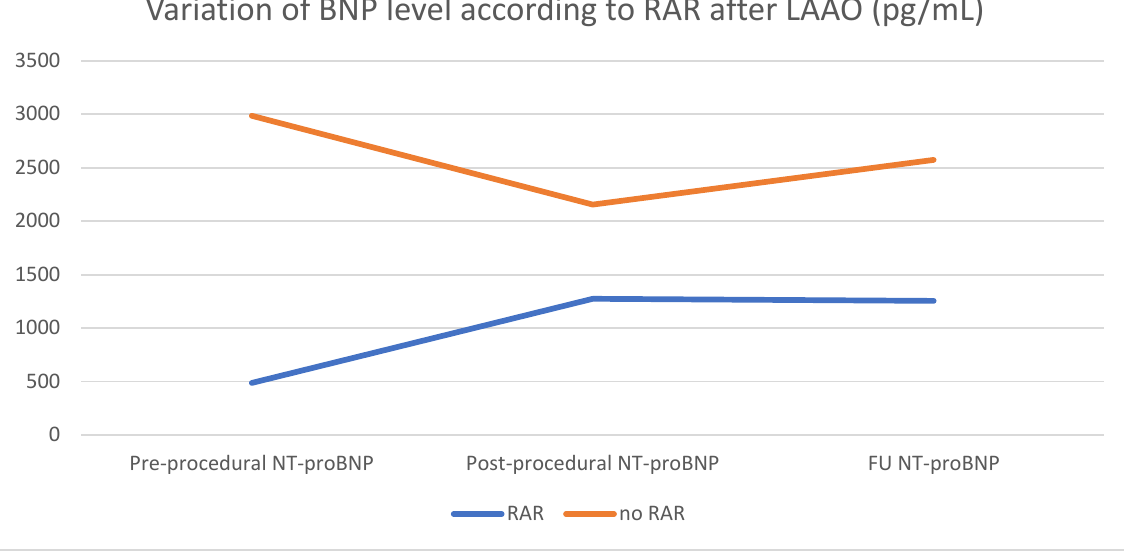
Figure 3. Variation of BNP level according to RAR after LAAO (pg/mL).